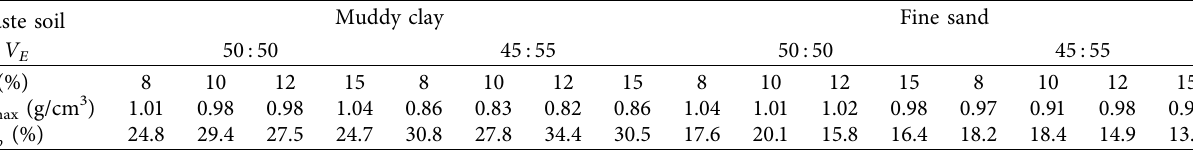
Table 2: Results of the compaction test.